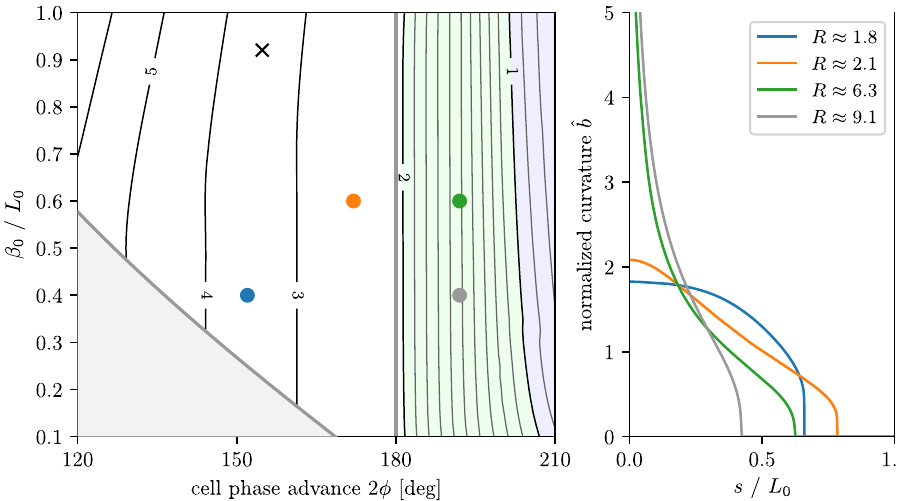
FIG. 6. TME emittance ratio F and example curvatures for free-form LGB cells with the constraint of positive curvature b ð s Þ ≥ 0 . Left: F in dependence of β 0 , ϕ (see legend in Fig. 5). Colored markers denote the curvature examples in the right plot. Right: curvature examples for setups marked in left plot.